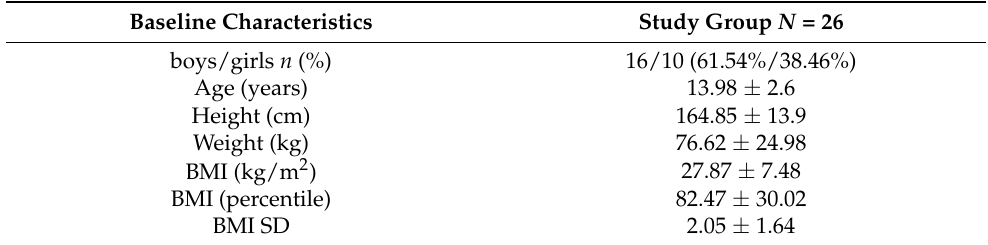
Table 2. Characteristics of the study group. Values are presented as mean ± standard deviation.